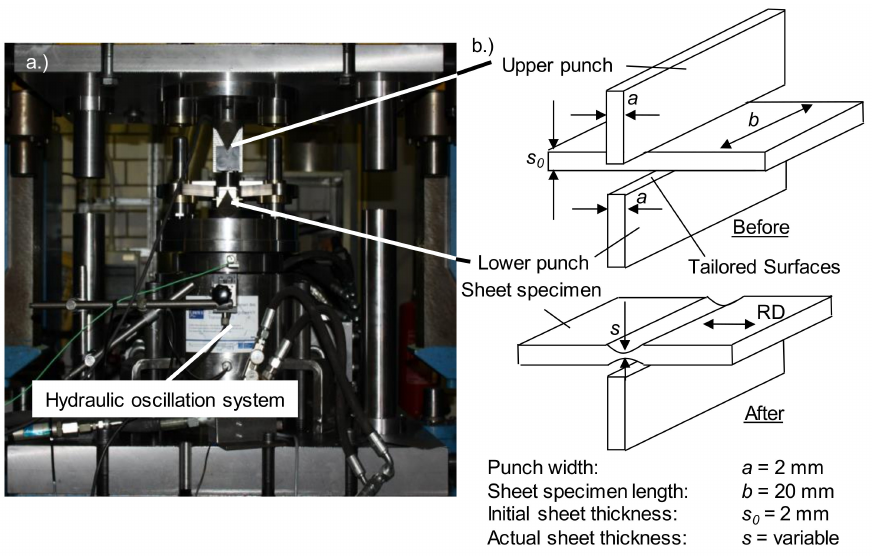
Figure 4. ( a ) Tool system and ( b ) specimen for plane-strain compression